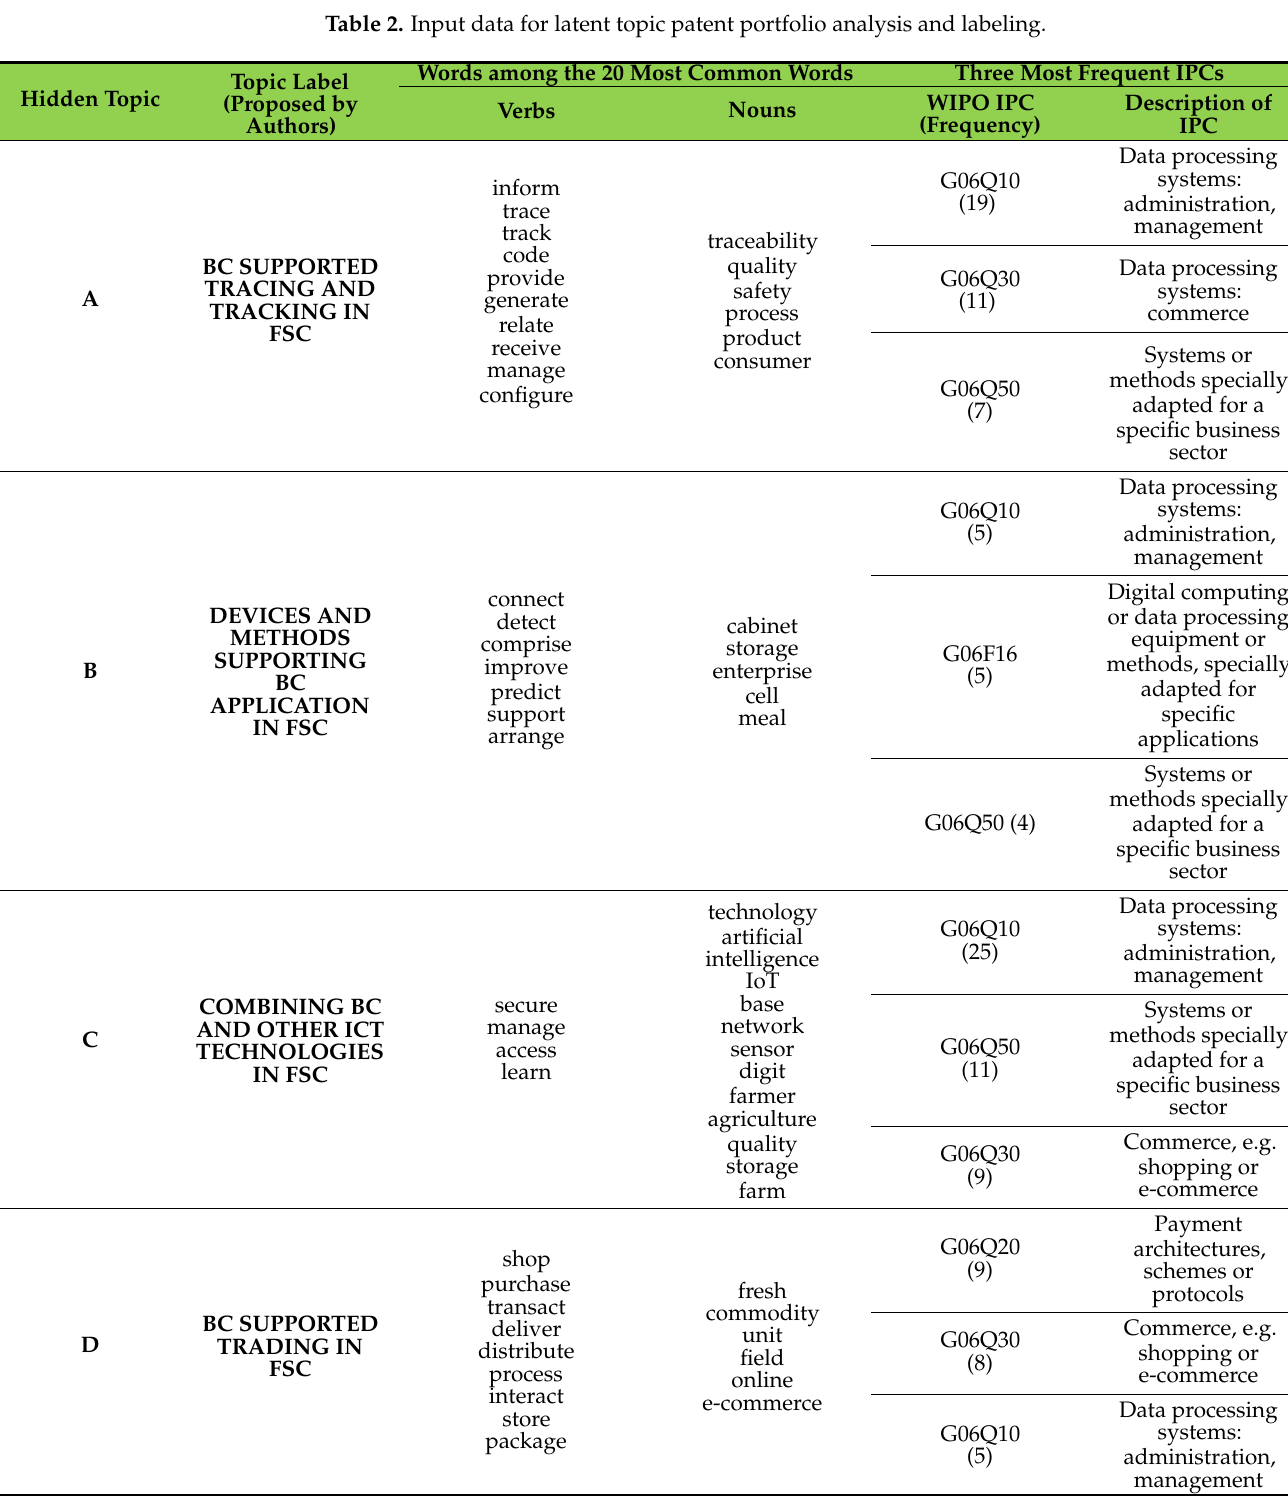
Table 2. Input data for latent topic patent portfolio analysis and